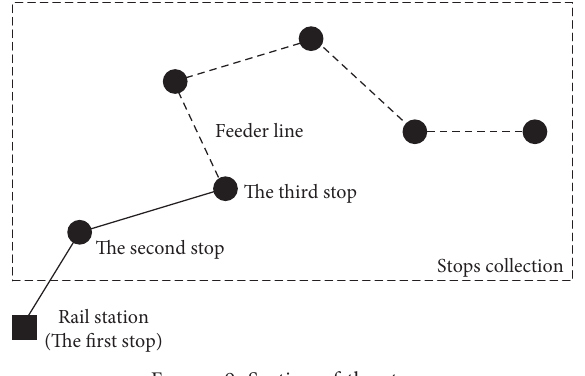
Figure 9: Sorting of the stops.